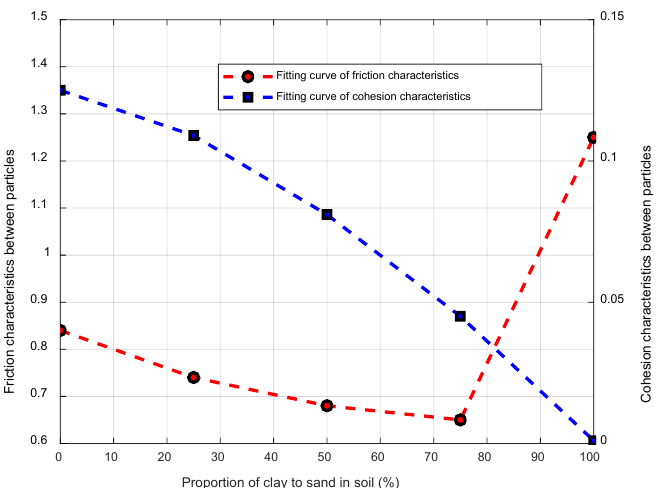
Figure 16. Friction and cohesion characteristics of different soils. The cohesion and friction characteristics of scaled-up particles were calibrated by DEM simulation. The two ordinates are the cohesion and friction of scaled-up soil particles. The abscissa is the soil composition.